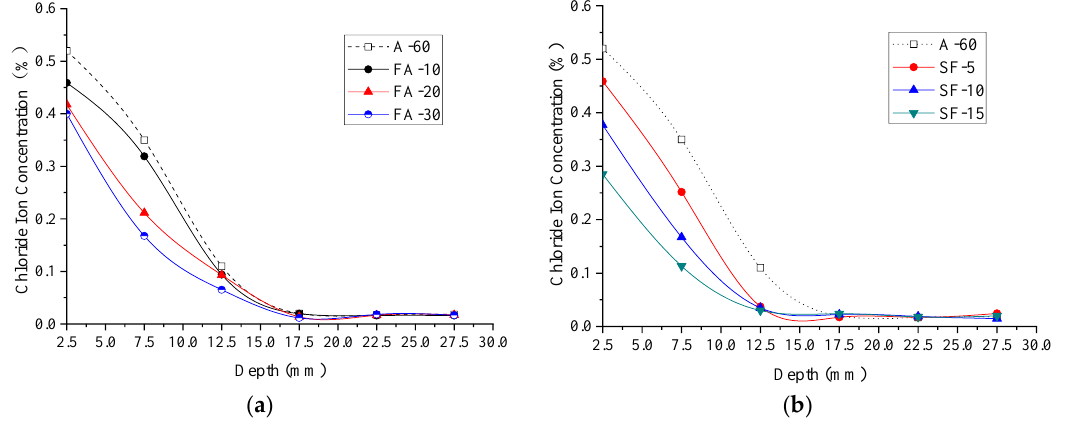
Figure 8. Chloride ion concentration of specimens with binary blends: ( a ) Portland cement – fly ash; ( b ) Portland cement – silica fume.